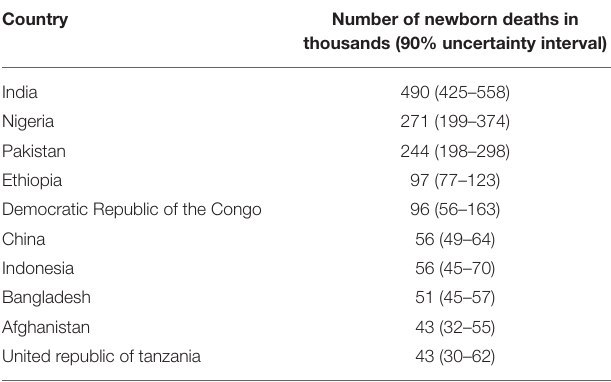
TABLE 1 | Top 10 countries with the highest number of neonatal deaths, 2020. Country Number of newborn deaths in thousands (90% uncertainty